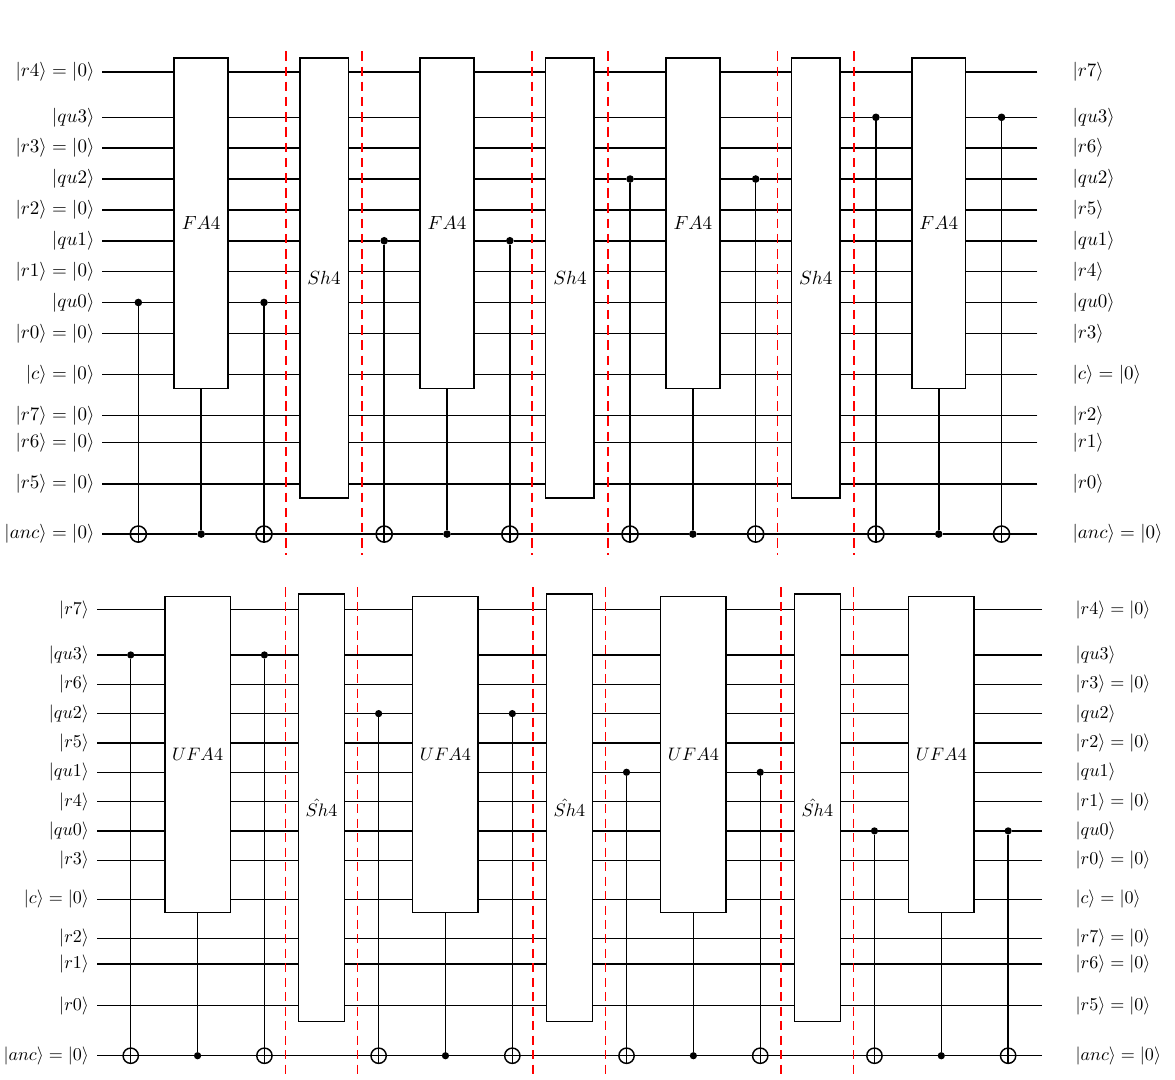
Figure 5. Quantum-circuit implementation of SQ 4 operation (and its un-computation ISQ 4) as used in the modified D1Q3 model and in the non-linear lattice model for 1D Burgers